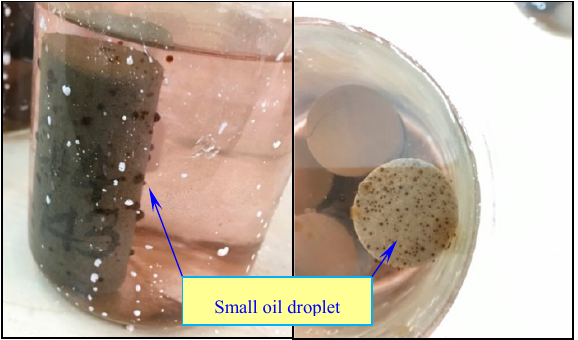
Figure 3. The small oil droplet displaced by water in UC7-1 samples.